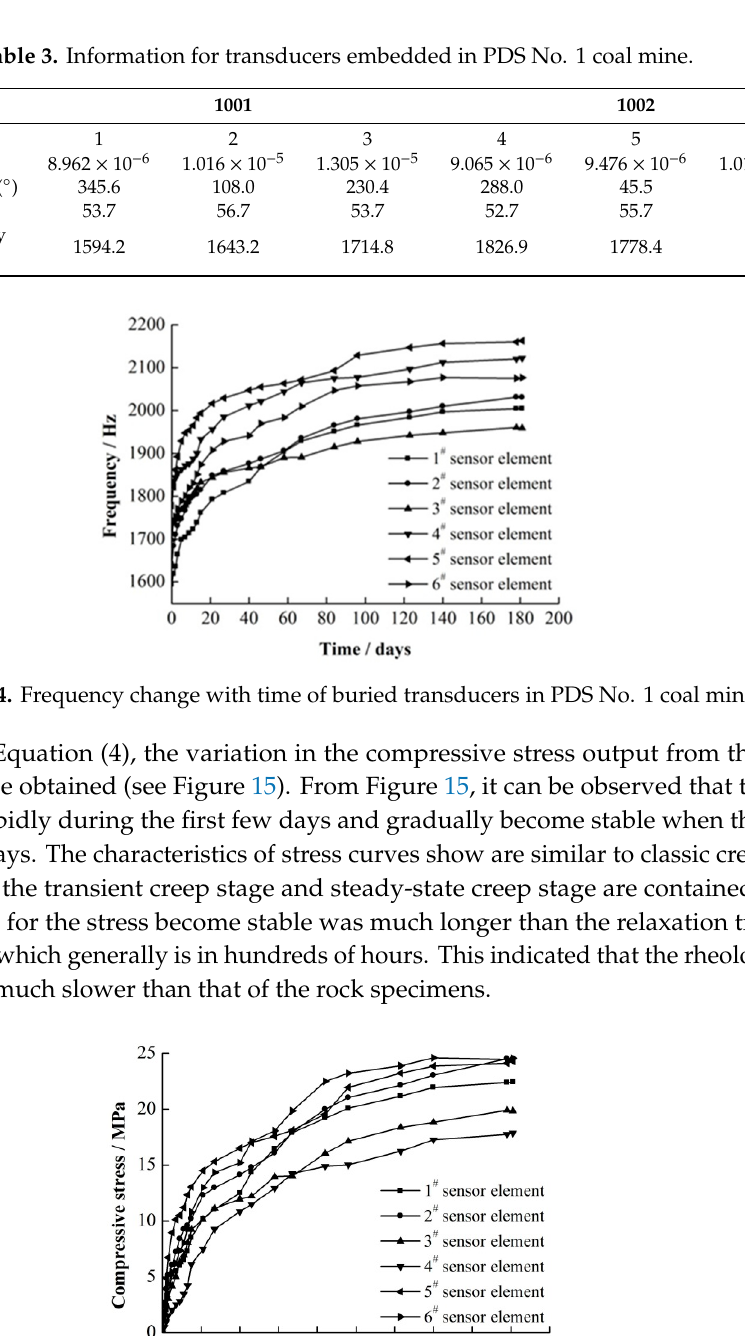
Figure 15. Comprehensive stress recovery curves for PDS No. 1 coal mine.